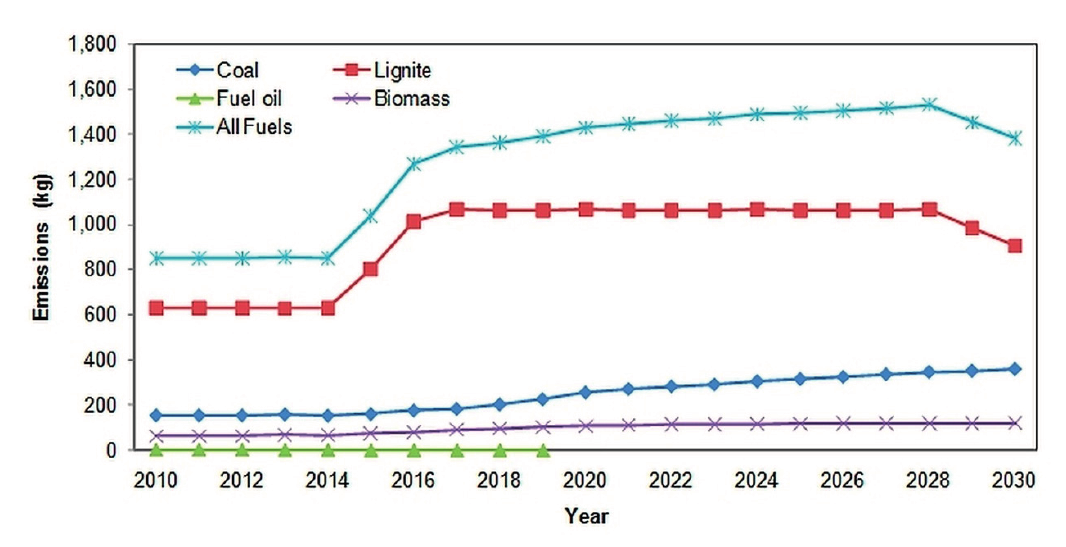
Figure 5. Hg Emission Trends from Power Generation to National Grid during